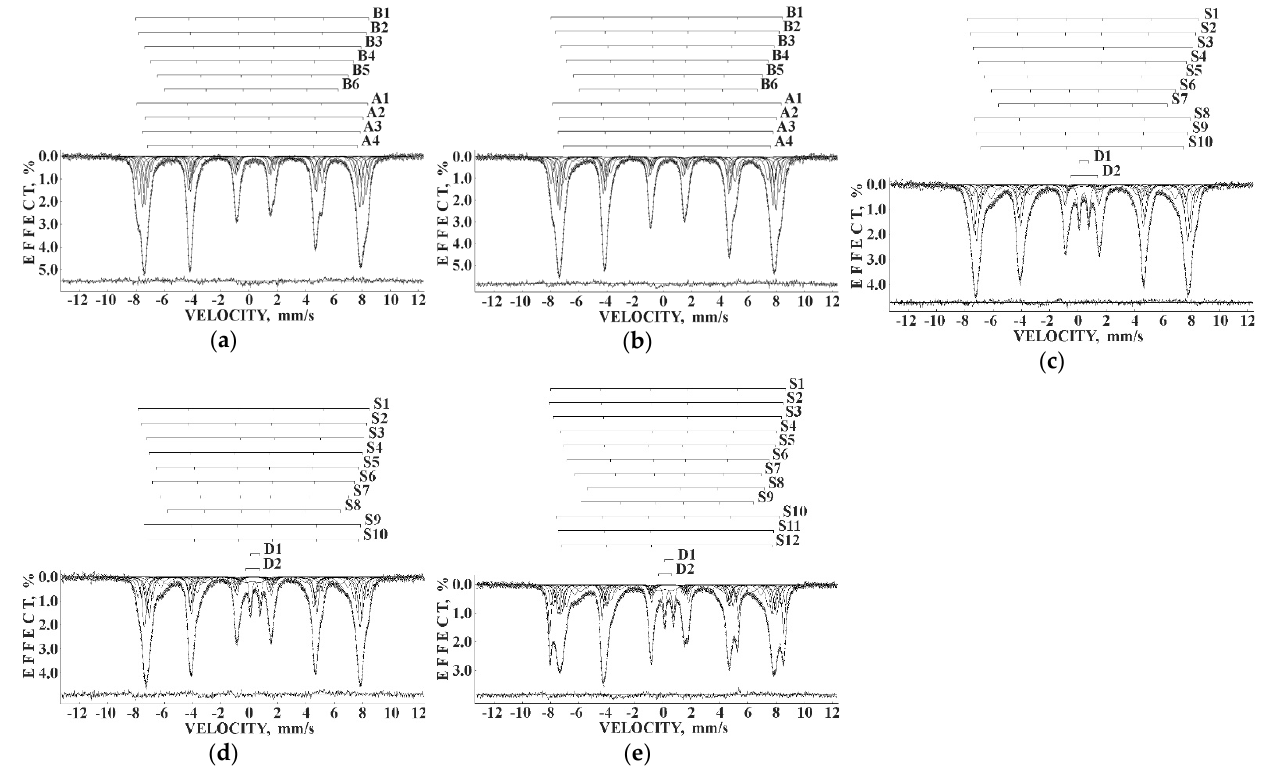
Figure 62. Refitted 1024 ‐ channel Mössbauer spectra of (CuFe 2 O 4 ) 1– x (SnO 2 ) x nanocomposites with x = 0 wt. % ( a ), x = 1 wt. % ( b ), x = 5 wt. % ( c ), x = 10 wt. % ( d ) and x = 20 wt. % ( e ). Indicated components are the results of the better fits (A1–A4 and B1–B6 are the magnetic sextets related to the (A) and [B] sites with different 57 Fe local microenvironments, respectively; S1–S12 are the magnetic sextets, D1 and D2 are the paramagnetic doublets). The differential spectra are shown on the bottom.